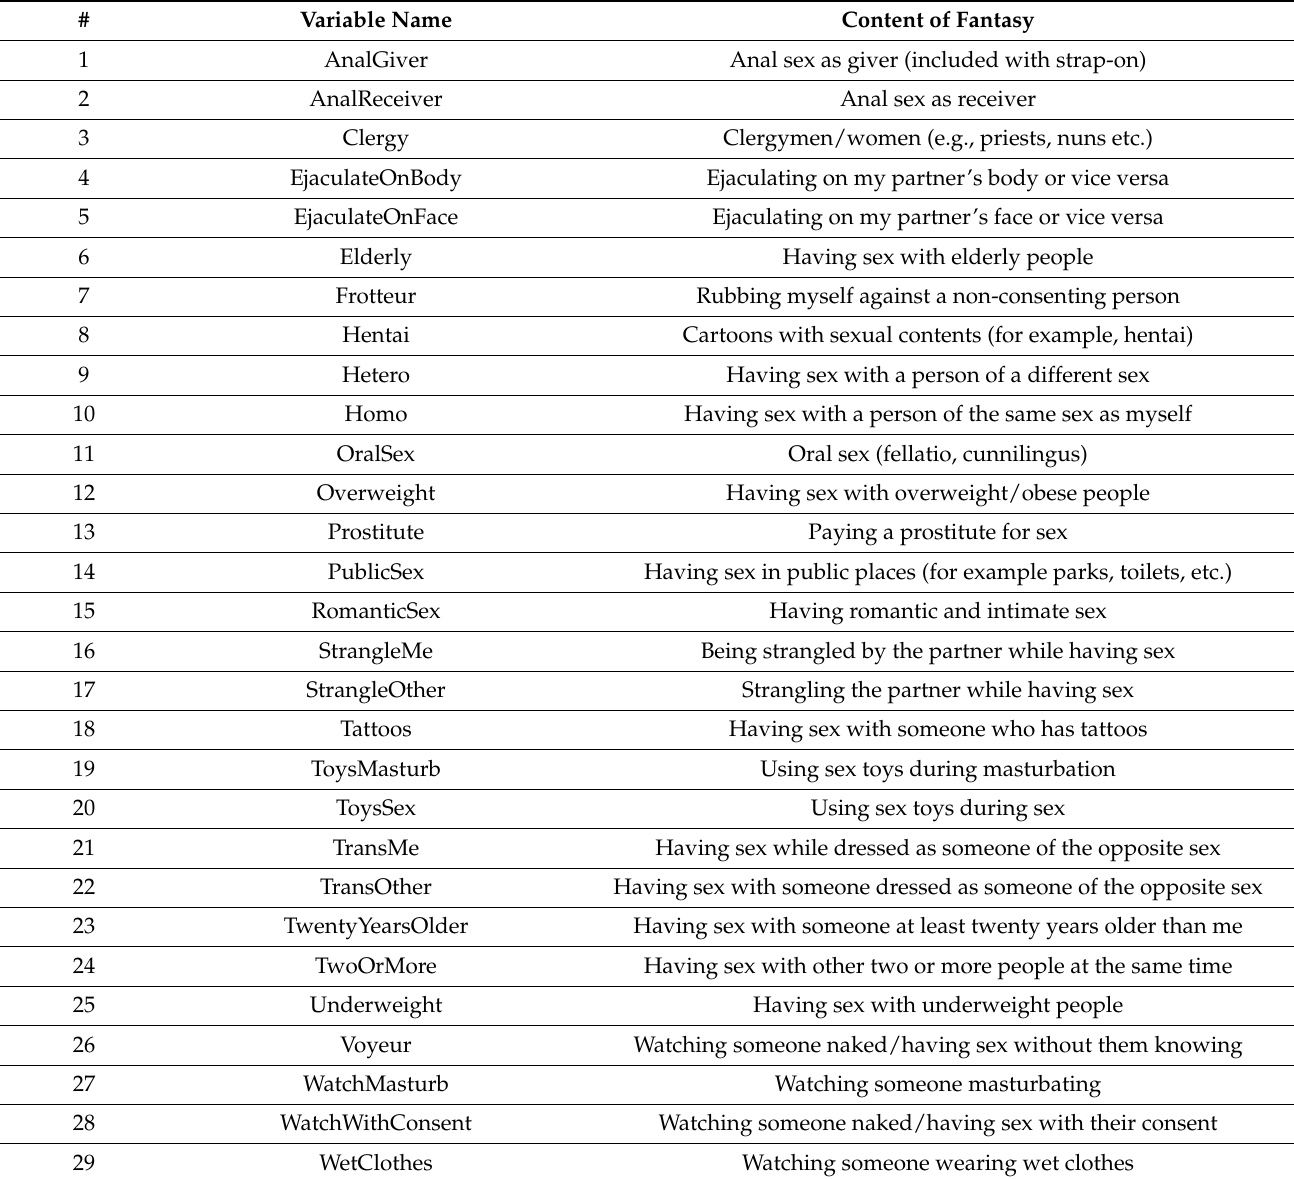
Table 1. Contents of assessed arousing sexual fantasies and assigned variables